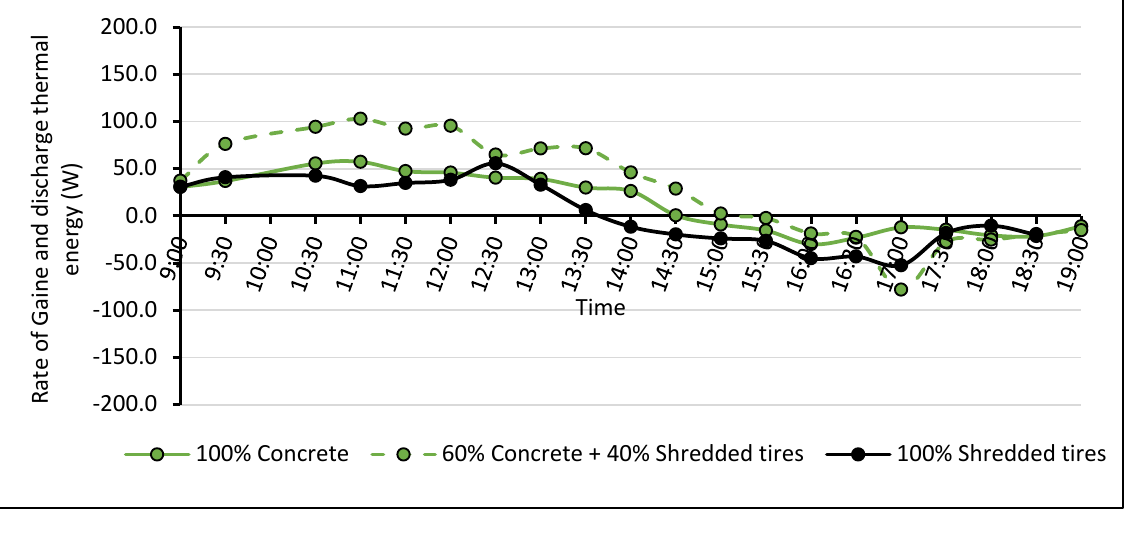
Figure 8. Comparison of thermal storage capacity of 100% concrete and the composite of 60% vol. concrete + 40% vol. shredded tires.